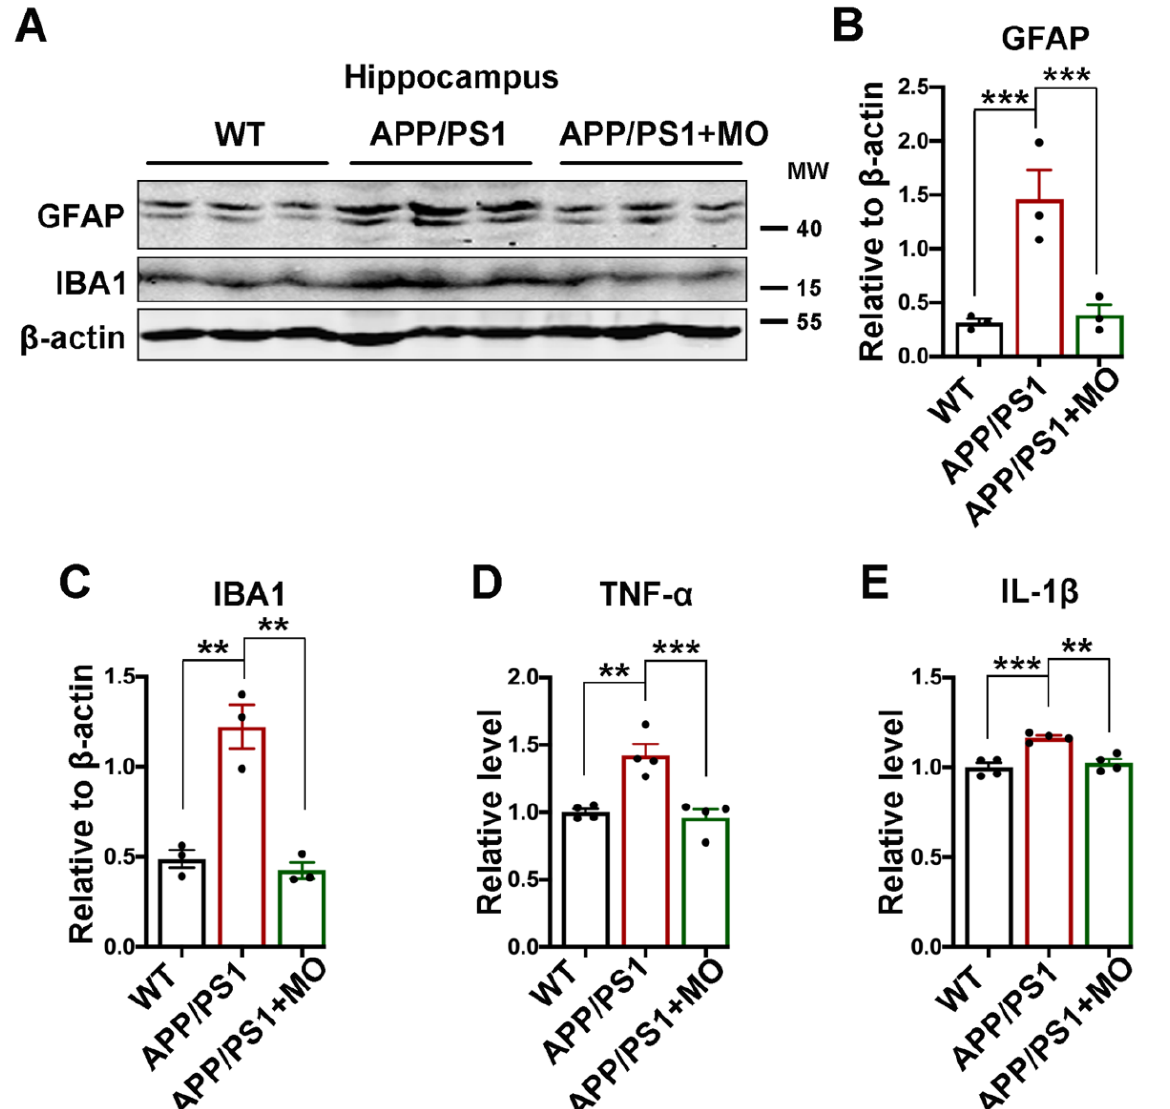
Figure 7. Long-term MO treatment alleviates neuroinflammation in APP/PS1 mice. ( A ) The expression level of GFAP and IBA1 from hippocampal lysates of WT control and APP/PS1 mice with or without MO treatment was evaluated by Western blotting, ( n = 3). ( B , C ) The statistical analysis of Western blot bands from panel A. β -actin serves as the loading control. ( D , E ) The statistical analysis of TNF- α and IL-1 β ELISA results from hippocampal lysates of WT control and APP/PS1 mice with or without MO treatment was evaluated, ( n = 4). The data are presented as Mean ± SEM. ** p < 0.01 and *** p < 0.001 vs. WT or vs. APP/PS1 mice